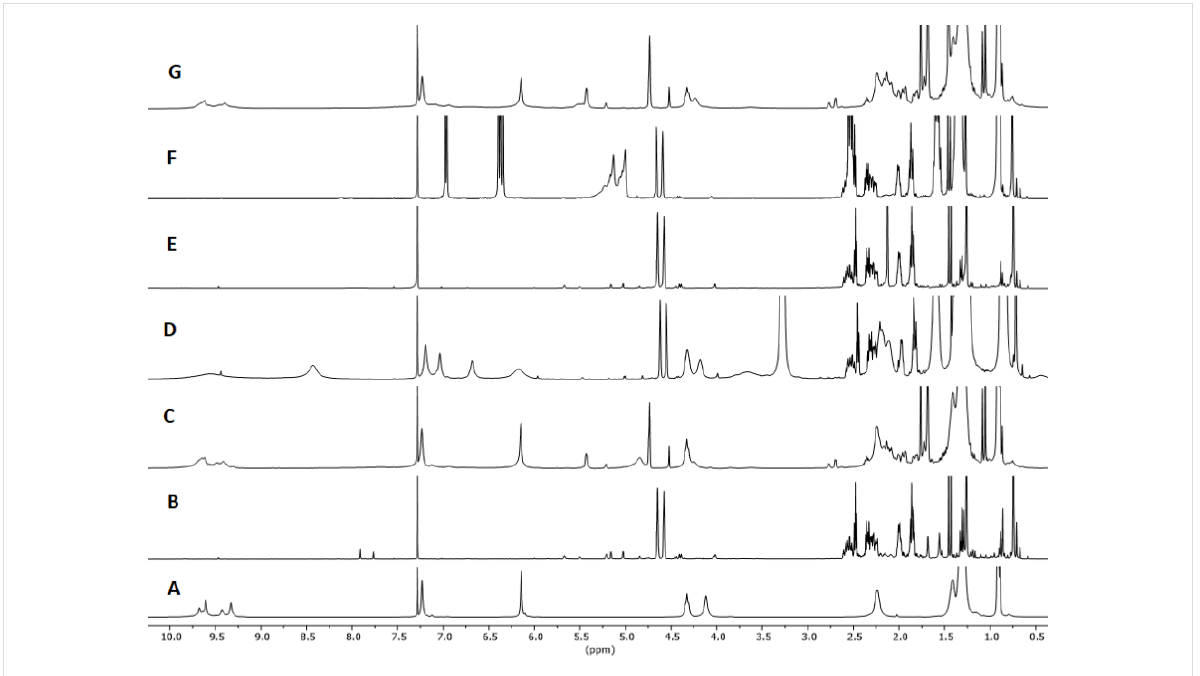
Figure 4: 1 H NMR spectra in water-saturated CDCl 3 except for G. A: [ 1 6 ] (7.5 mM); B: β -pinene; C: β -pinene (75 mM), [ 1 6 ] (7.5 mM); D: β -pinene (75 mM), [ 1 6 ] (7.5 mM), Bu 4 NBr ( 3 , 78 mM); E: β -pinene (75 mM), acetic acid (29 mM); F: β -pinene (75 mM), n -hexylresorcinol ( 2 , 30 mM); G: